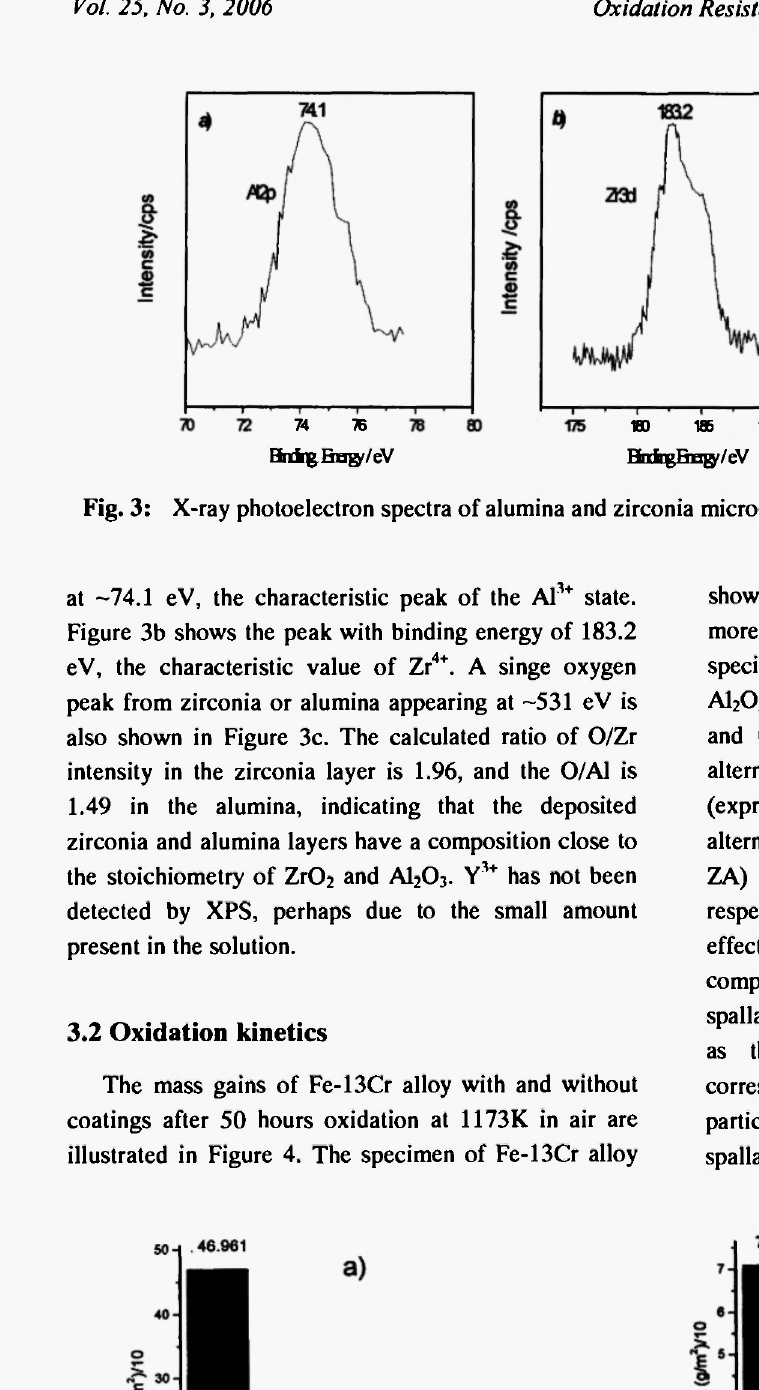
Fig. 3: X-ray photoelectron spectra of alumina and zirconia micro-laminated coatings: a) A12p, b) Zr3d, and c) Ols.